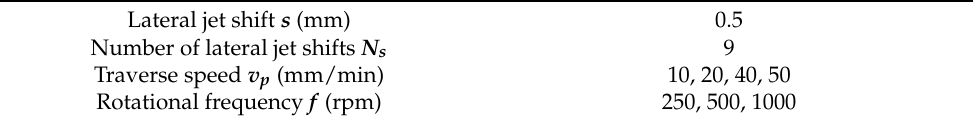
Table 3. Experimental setup with different combinations of traverse speed and rotational